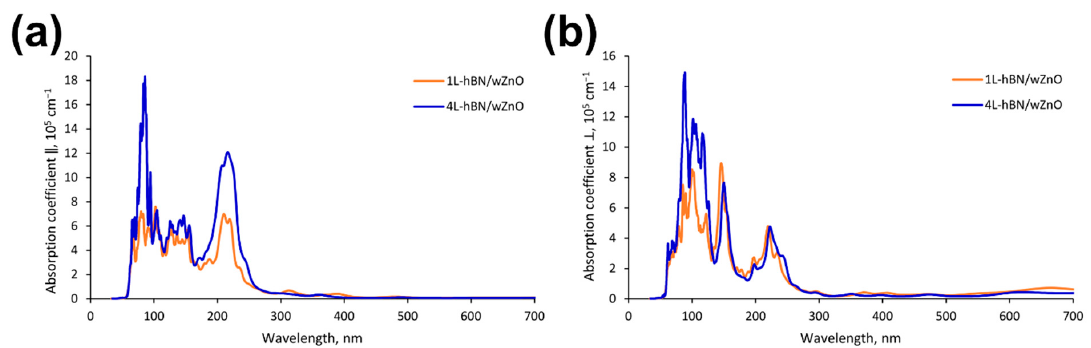
Figure 9. Dependence of the extinction coefficient of h-BN/ w ZnO heterostructures on the irradiation wavelength in ( a ) transverse and ( b ) perpendicular directions to the surface.